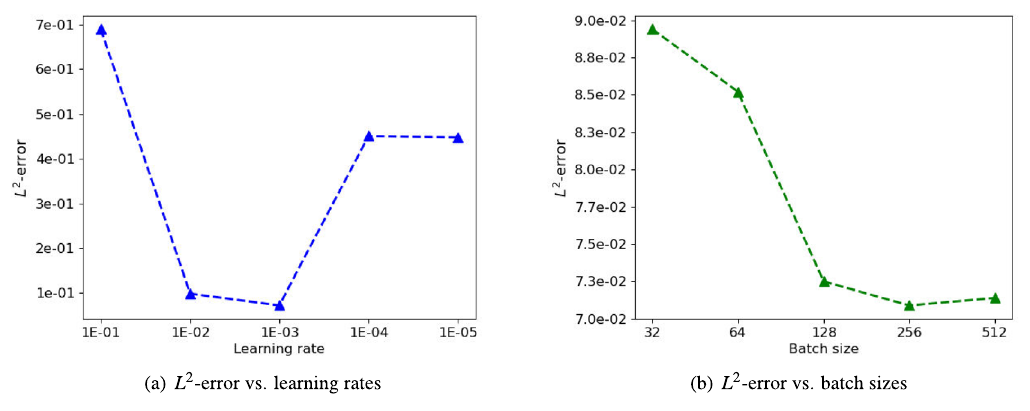
Figure 10. A comparison of the L 2 -error for different learning rates and batch